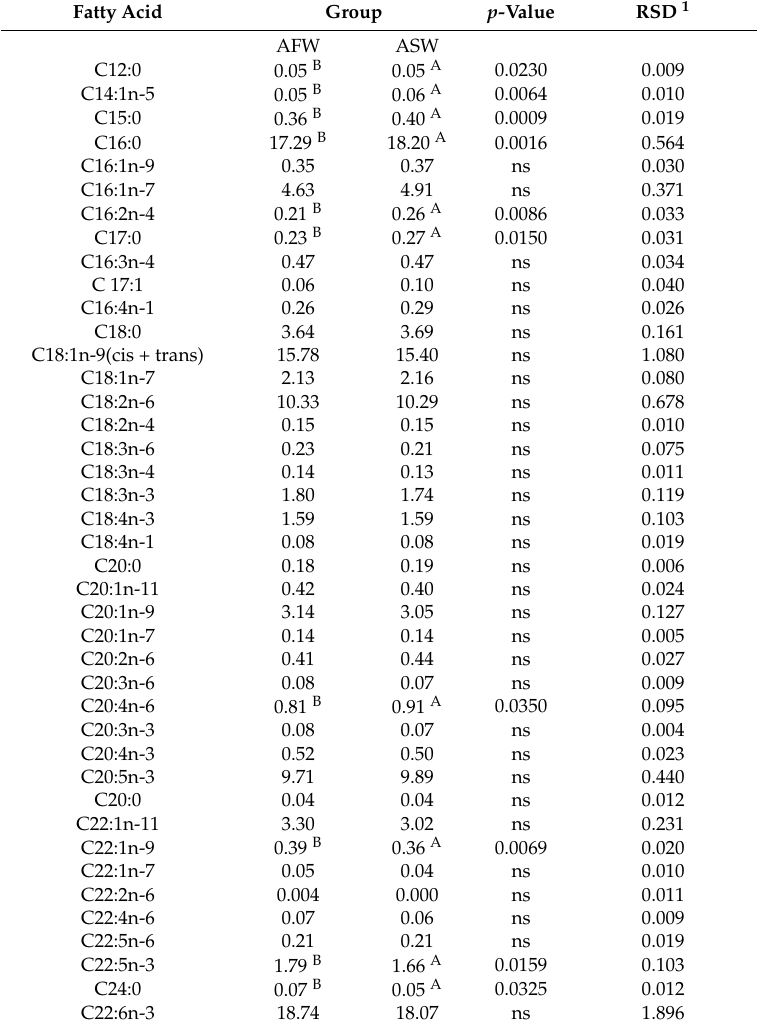
Table 5. Fatty acid profile (in % of total fatty acids) of the fillet in European sea bass muscle, reared in AFW and